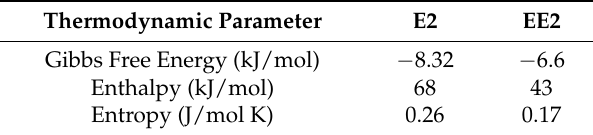
Table 4. Thermodynamic parameters for E2 and EE2 at pH